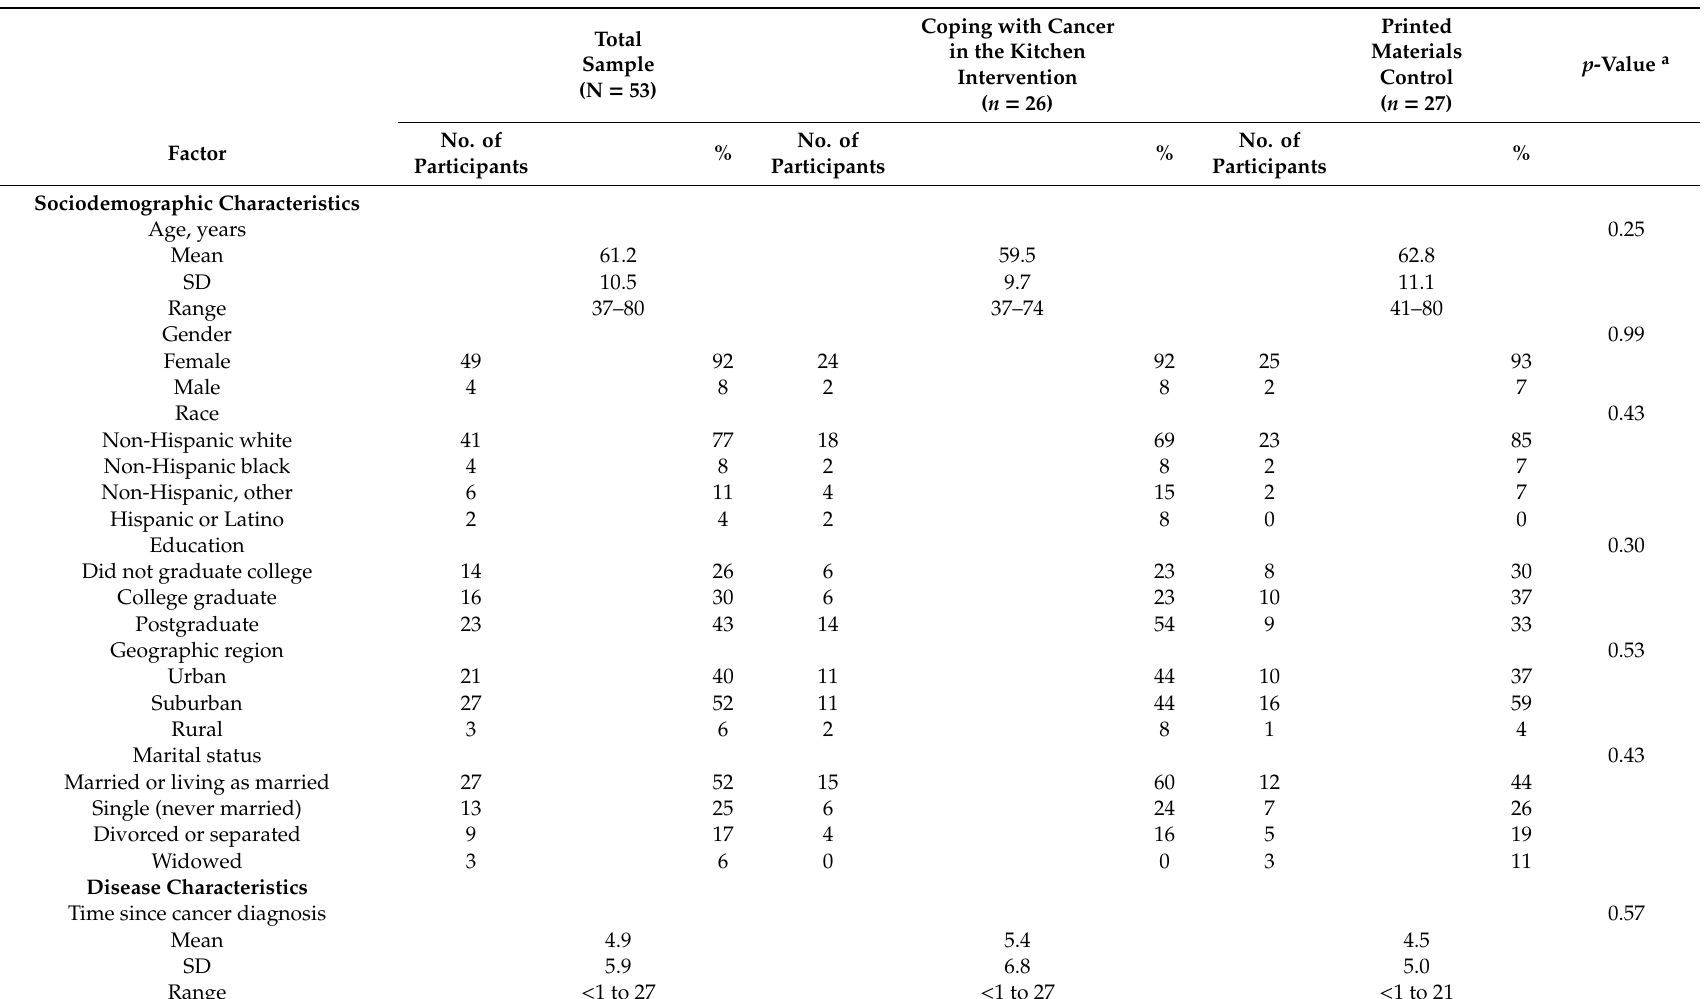
Table 2. Sociodemographic and disease characteristics of cancer survivors participating in a randomized study of Coping with Cancer in the Kitchen